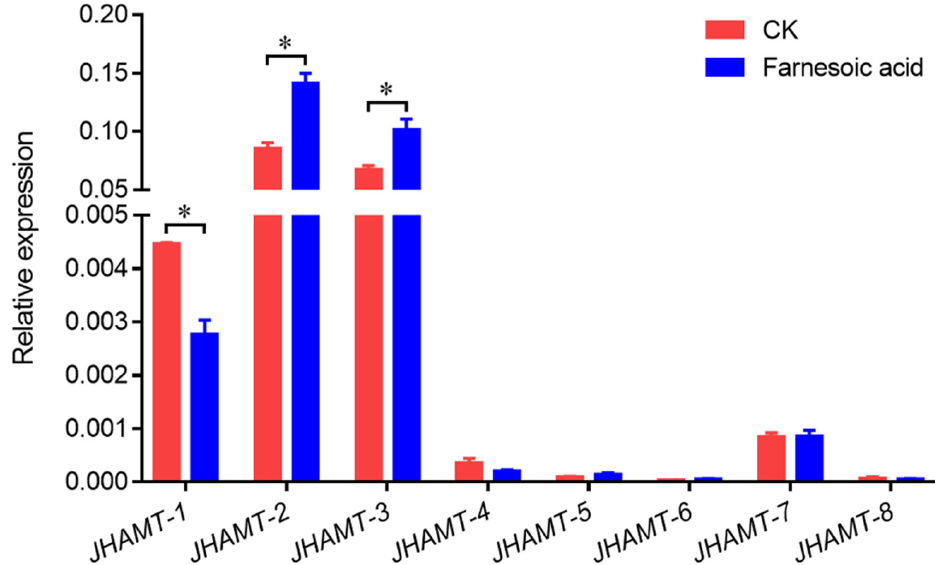
Figure 5. Relative expressions of eight JHAMT genes in farnesoic acid-applied the second-instar spiderlings. CK, control group containing 200 time-diluted ethanol. *, p < 0.05.